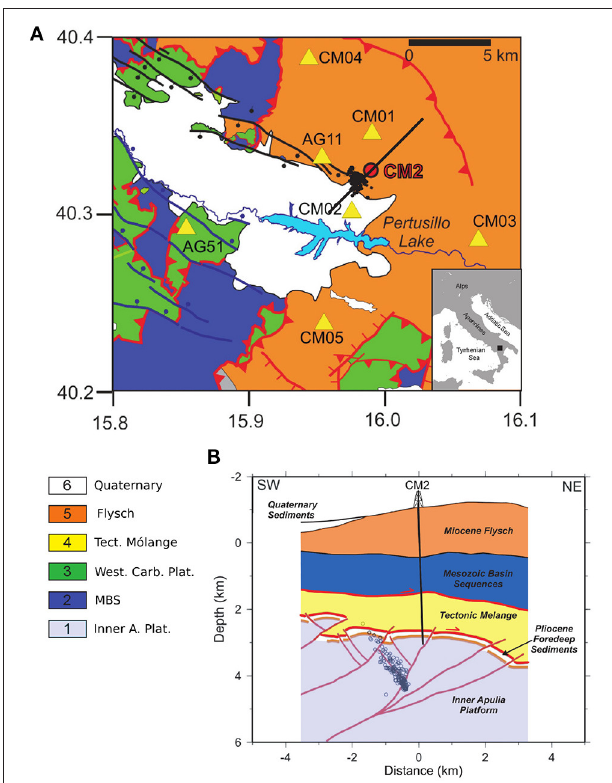
FIGURE 1 | (A) Geologic map of the southern sector of the Val d’Agri (modified after; Improta et al., 2017). 1—Inner Apulia platform (Mesozoic–Miocene); 2—deep basin pelagic sequences (Mesozoic); 3—Western carbonate platform (Mesozoic); 4—Tectonic mólange (Late Miocene–Lower Pliocene); 5—Flysch deposits, pelagic-slope successions (Miocene); 6—Quaternary continental deposits. Red lines denote main reverse faults; blue and black thick lines denote Quaternary normal-fault systems; yellow triangles are seismic stations used in this study; the red circle is the injection well CM2. The black dots denote the epicenters of the 2006–2014 fluid injection induced earthquakes analyzed by Improta et al. (2017). (B) Schematic geologic cross-section across the CM2 well injection site. The trace of the section is reported in map with a thick line. The black circles denote the 2006–2014 fluid injection induced earthquakes located through the double-difference method by Improta et al. (2017). The schematic geologic model is modified after Buttinelli et al. (2016) and Improta et al.